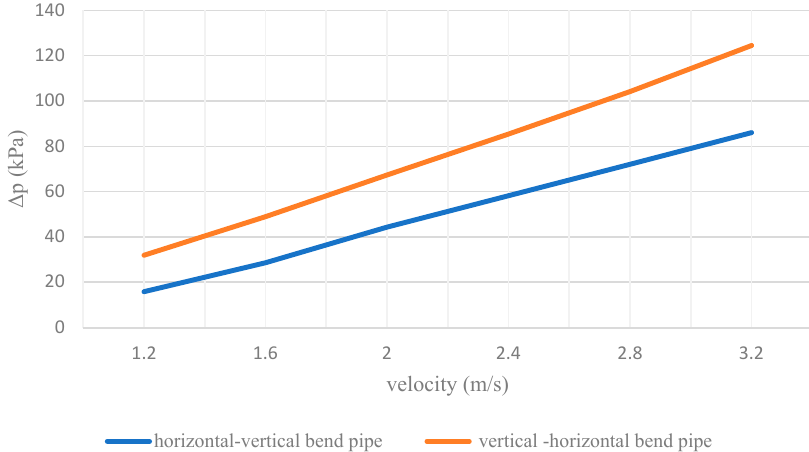
Figure 9. Pressure loss of two types of bend pipe.